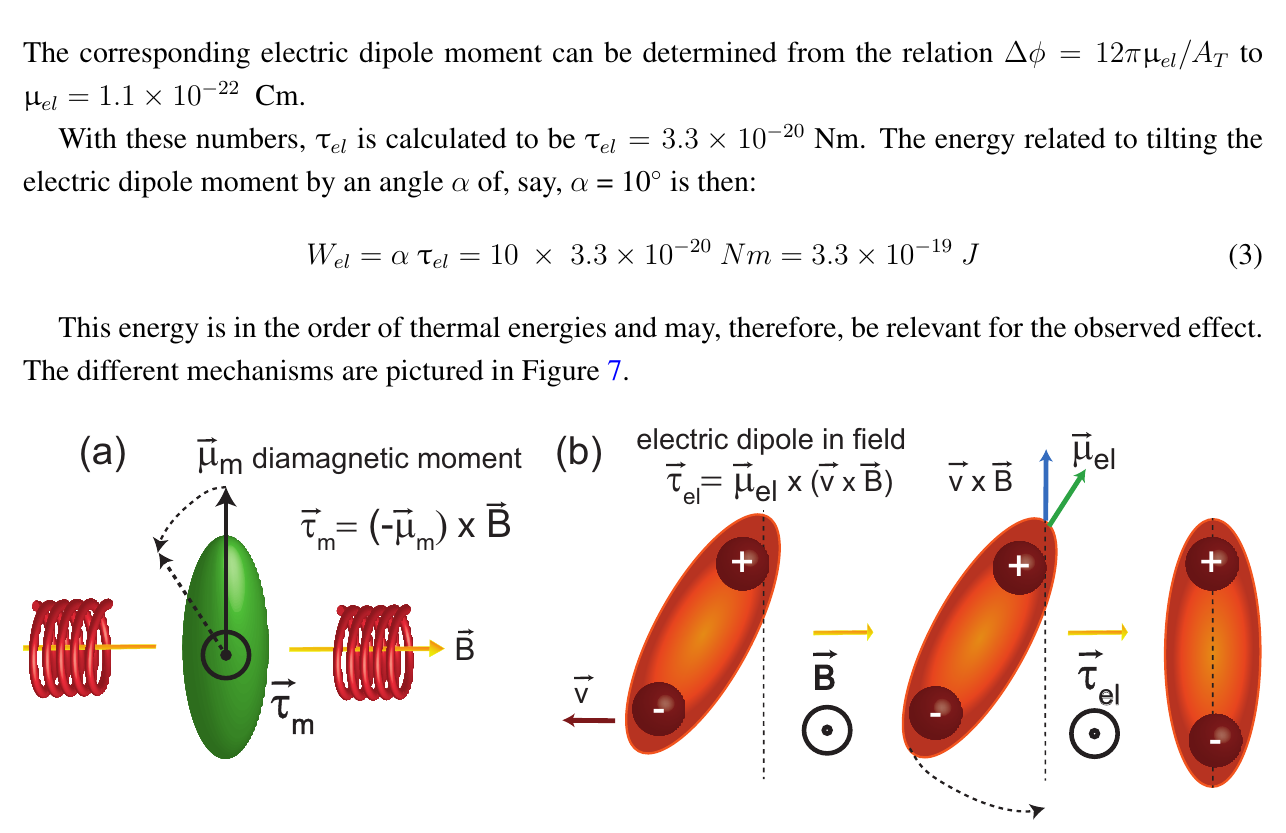
Figure 7. Interaction between a magnetic moment ( a ) and an electric dipole moment ( b ) and an external magnetic field. The magnetic moment experiences a torque, τ direction of the magnetic field. The torque on a fluctuating electric dipole is acting to align it with the bilayer normal. While the magnetic energy E as compared to thermal energies ( E 10 ◦ tilt of the electric dipole is calculated to W E . See text for thermal